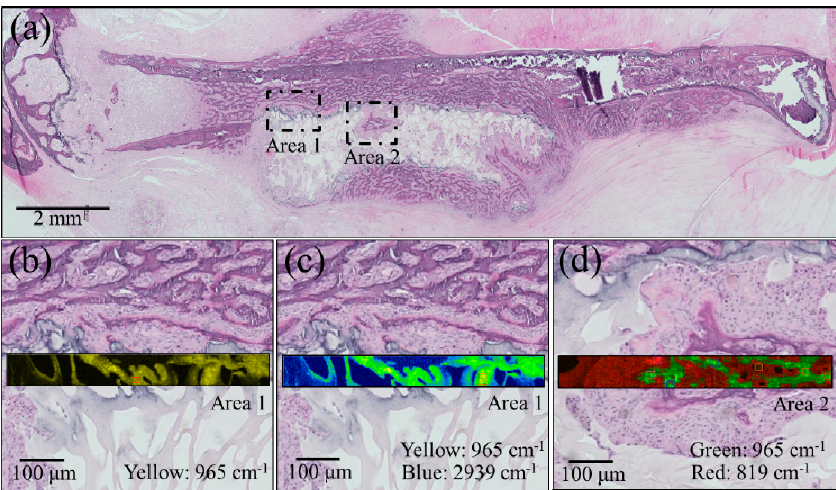
Figure 4. ( a ) Low-resolution histological image of the regenerated bone treated with the NanoCliP-FD scaffold; enlargements of the square insets are shown in ( b ) and ( c ) for Area 1 and in ( d ) for Area 2. In the enlarged pictures, Raman maps are shown in yellow for the intensity of the apatite mineral band PO 43 − located at ~965 cm − 1 ( b ); for the 965 cm − 1 PO 43 − band (yellow) and the CH 2 region from collagen ~2939 cm − 1 (blue); for the 965 cm − 1 PO 43 − band (green) and the CCH band at 819 cm − 1 (red) belonging to the collagen matrix.